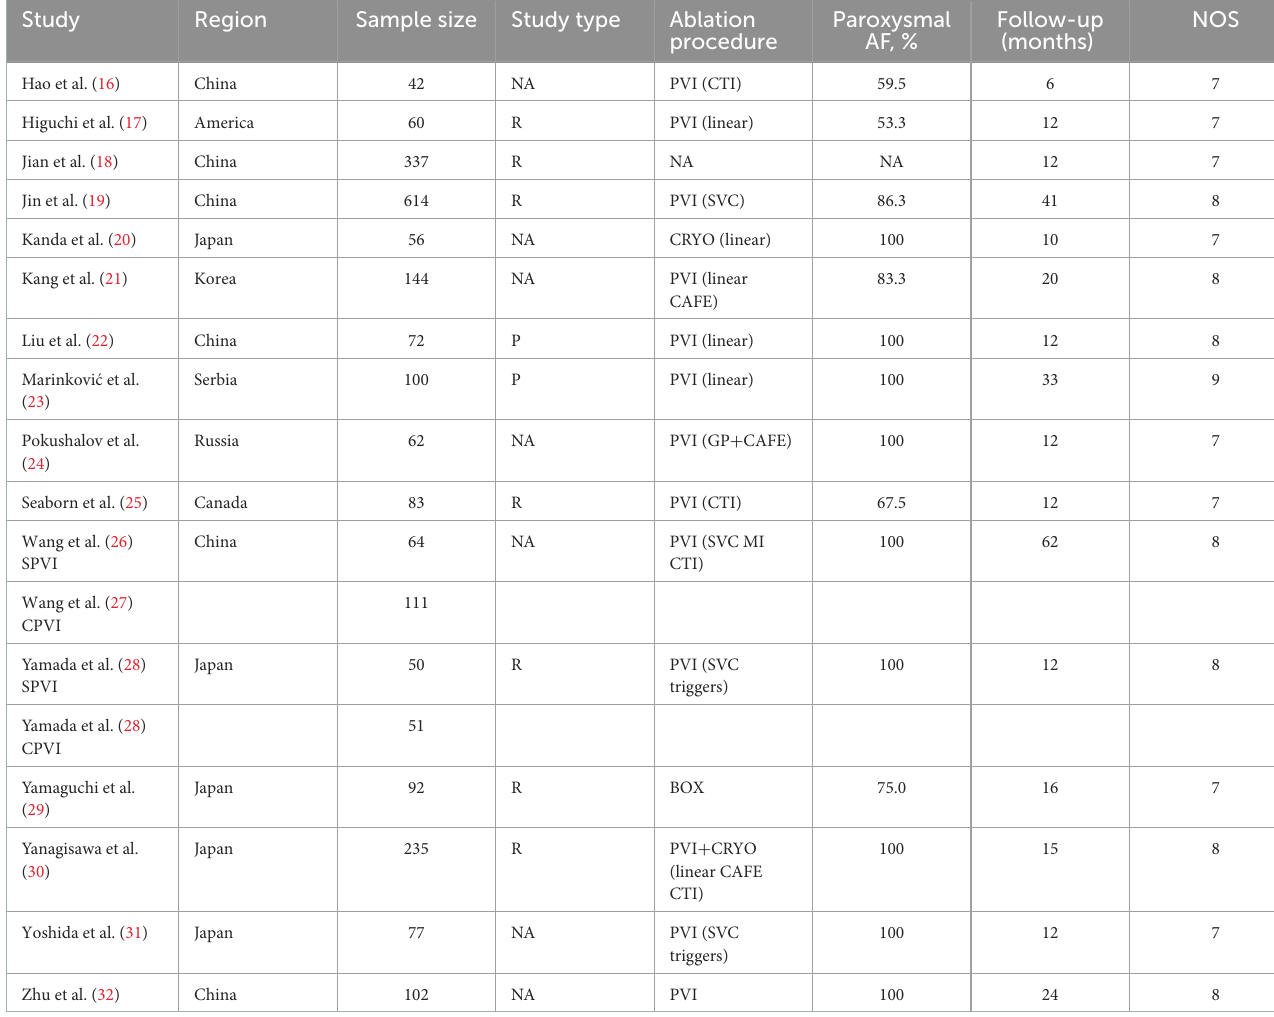
TABLE 2 The characteristics of all studies included in the systematic